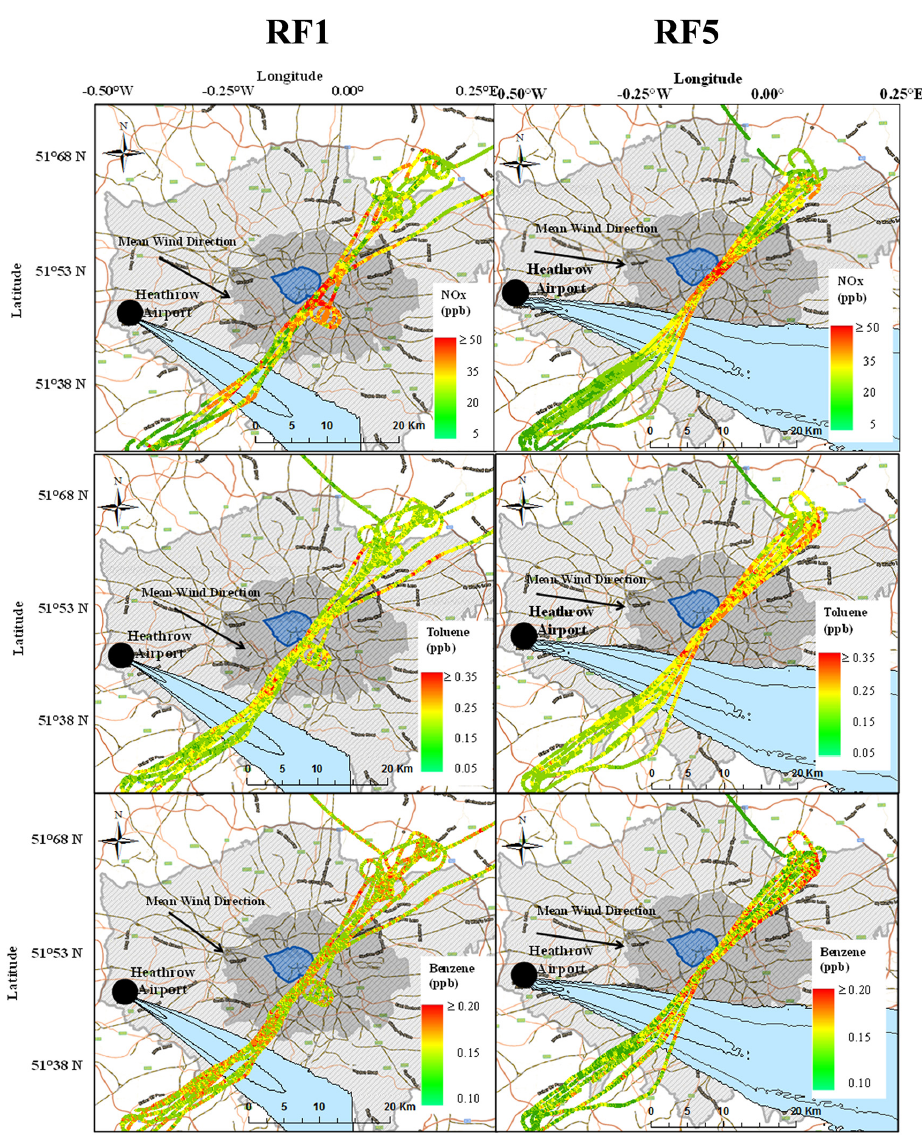
Figure 6. Top: NO x concentration data (7m resolved at 360 ± 10ma.g.l.) during RF1 (left) and RF5 (right) overlaid on UK transport map. Middle: Benzene concentration data (35m resolved at 360 ± 10ma.g.l.) during RF 1 (left) and RF5 (right) overlaid on UK transport map. Bottom: Toluene concentration data (35m resolved at 360 ± 10ma.g.l.) during RF1 (left) and RF5 (right) overlaid on UK transport map. Grey area: Greater London boundary; black area: inner London boundary; dark blue area: London CCZ; light blue area: 4h averaged HYSPLIT dispersion